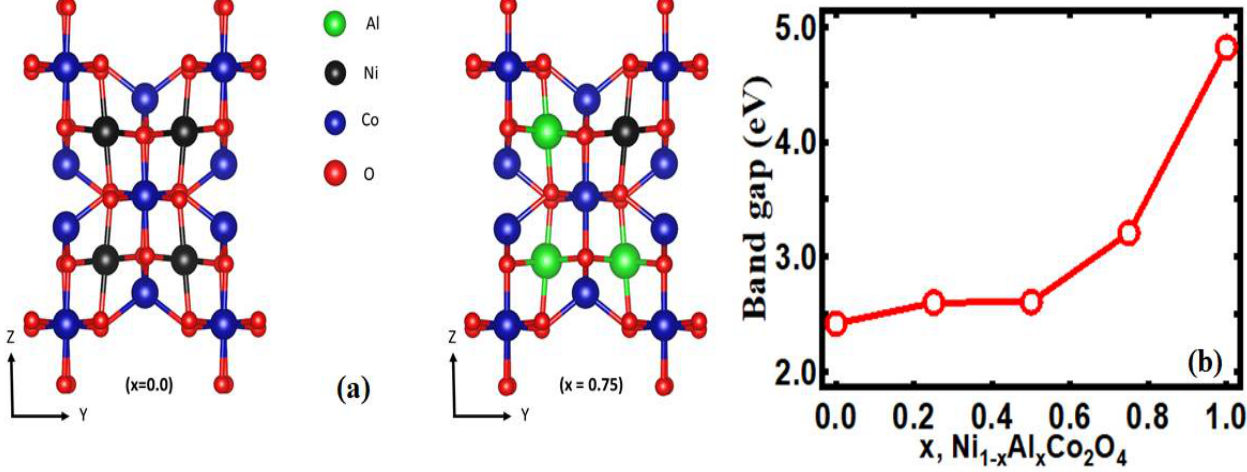
Figure 9. ( a ) Side view, along the x-axis of the crystal structure and ( b ) energy band-gap of Ni 1 − x Al x Co 2 O 4 obtained from DFT calculations as a function of content, x .